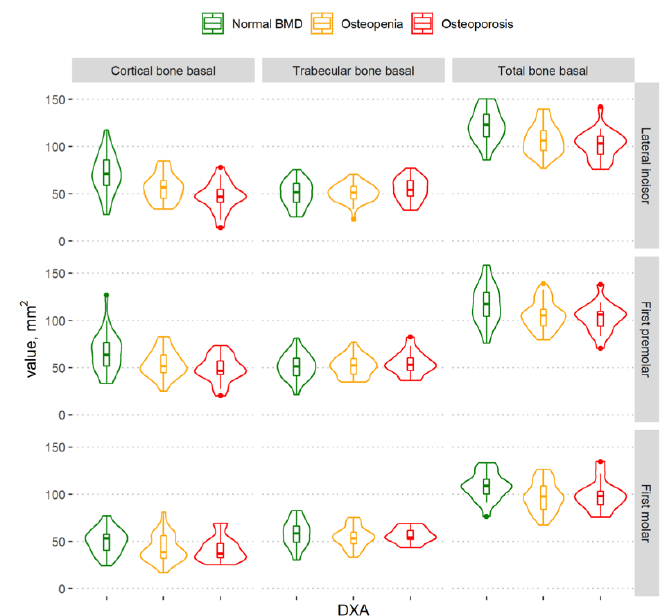
Figure 5. Violin plots of the cortical, trabecular, and total bone volume measurements in the different BMD groups in the regions of the lateral incisor, first premolar, and first molar in the basal part of the mandibular body. Table 2. Means, standard deviations, and one-way ANOVA results for total bone volume, trabecular bone volume, and cortical bone volume in the complete, alveolar part, and basal part of the mandibular body in the normal BMD, osteopenia, and osteoporosis groups.